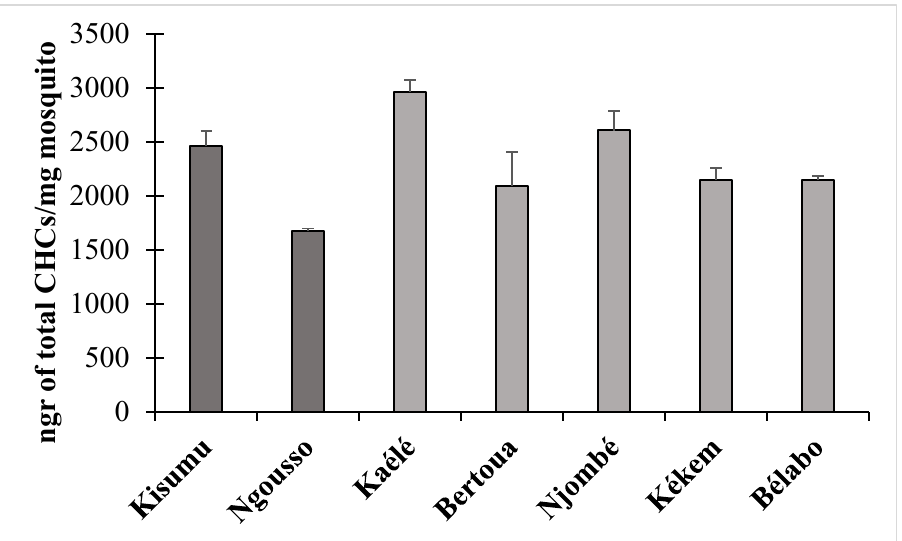
Figure 5. Mean CHC amounts from Anopheles gambiae populations from Kaélé, Bertoua, Njombé, Kékem and Bélabo (Cameroon).